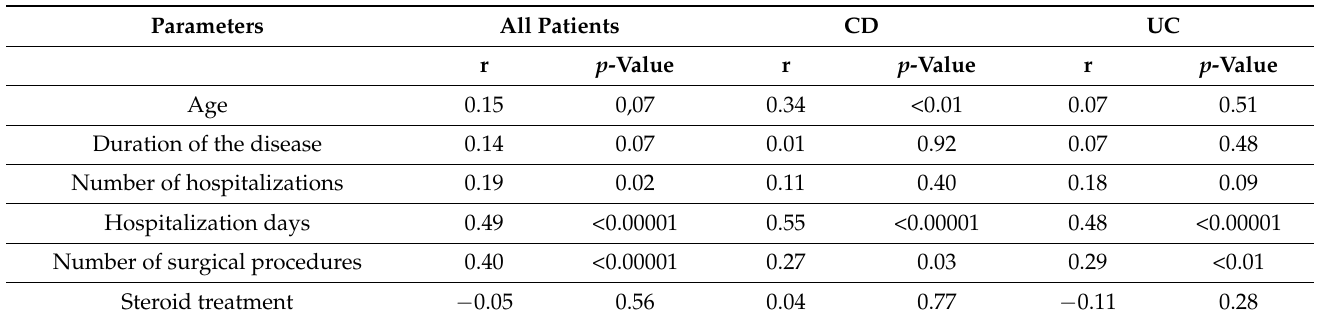
Table 4. Correlation of individual parameters with cumulative effective dose.